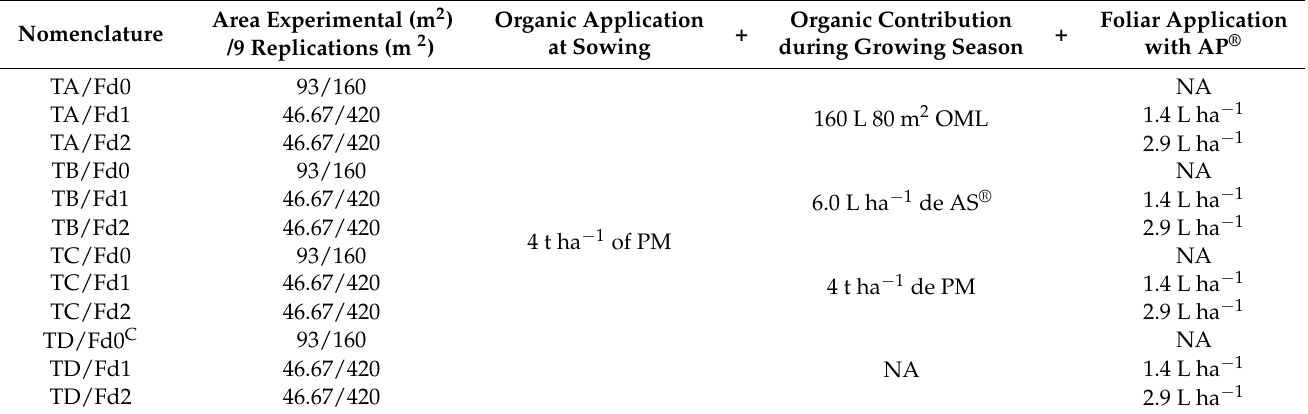
Table 1. Organic fertilization in different treatments during standing cultivation.